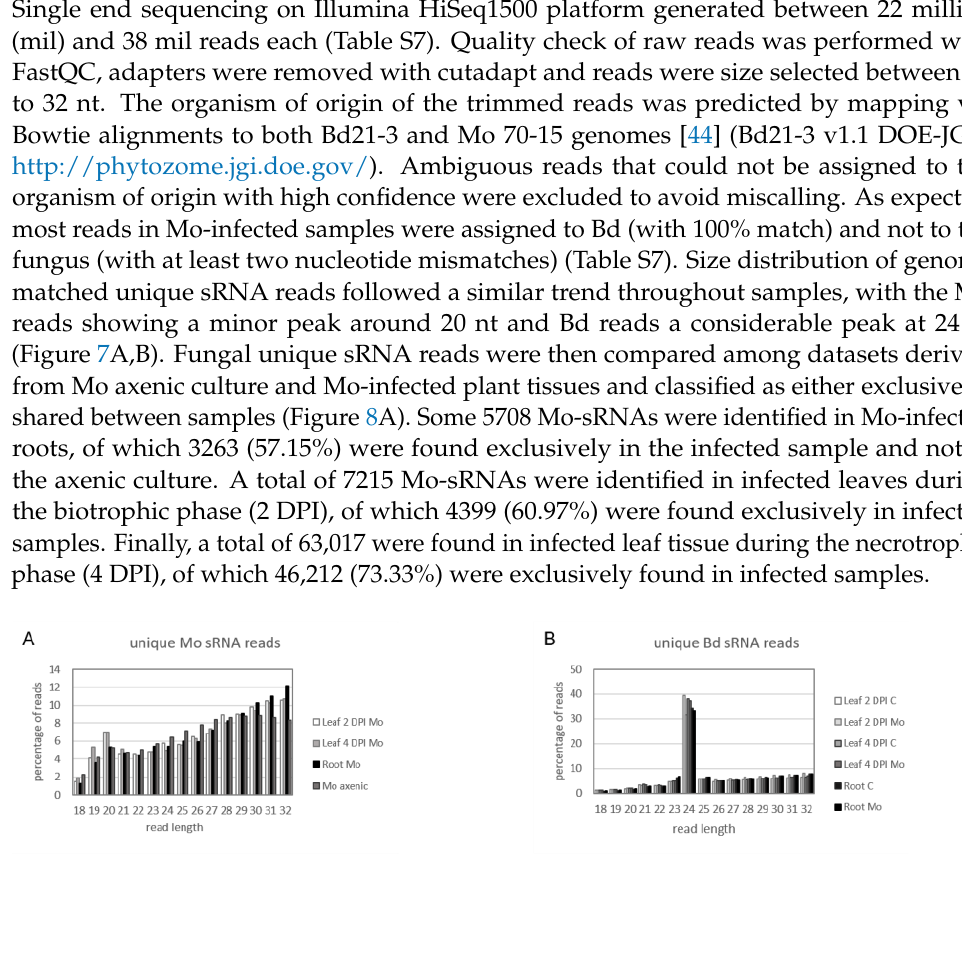
Figure 8. Venn diagrams of unique filtered sRNAs reads from M. oryzae and B. distachyon . ( A ) Venn diagram of Mo sRNA reads (18–32 nt) from axenic culture and Mo-infected Bd leaves (2 DPI, 4 DPI) and roots (4 DPI). ( B ) Venn diagram of Bd sRNA reads (18–32 nt) in non-infected and Mo-infected Bd leaves.